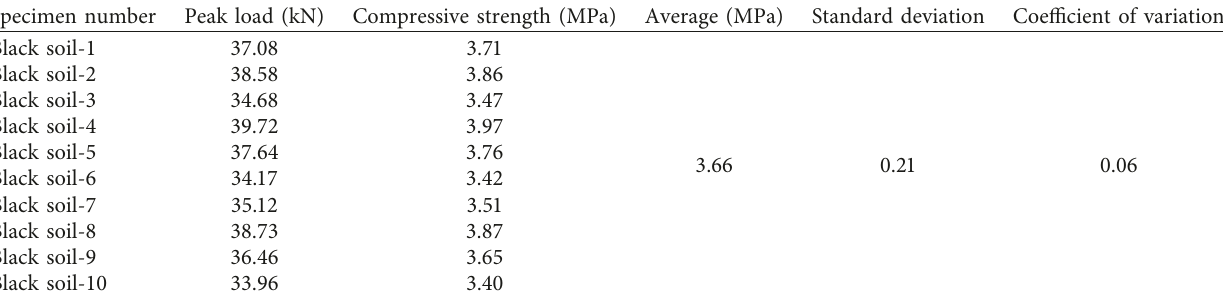
Table 3: Results from black soil cubes.